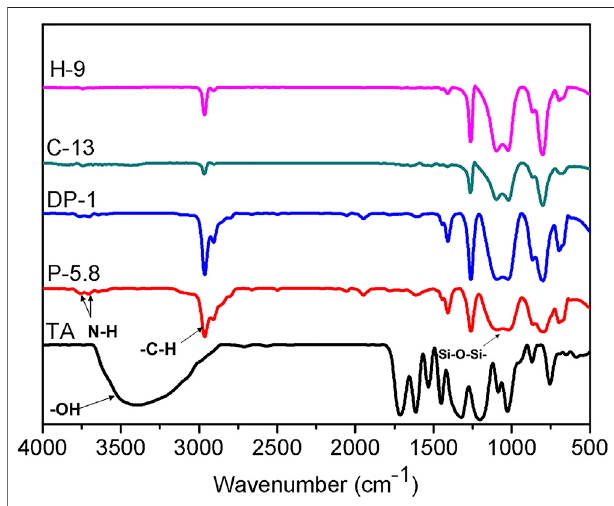
FIGURE 2 | FT-IR spectra of TA, P-5.8, DP-1, C-13, and